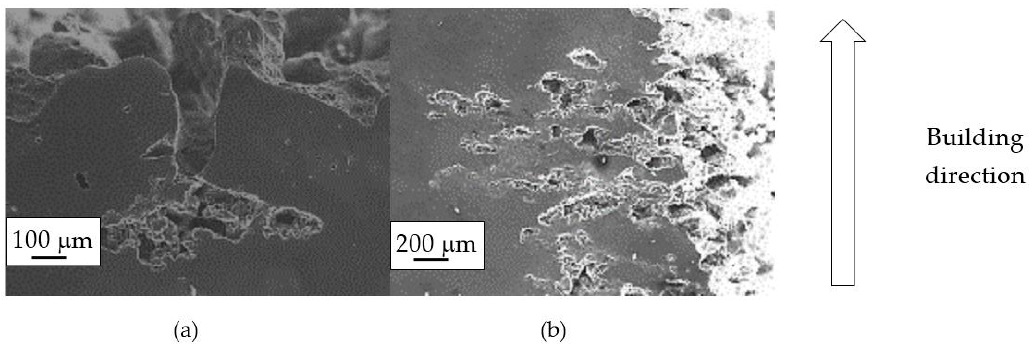
Figure 2. Metallographic section after ISO 11846 test on a specimen heat treated at 300 °C